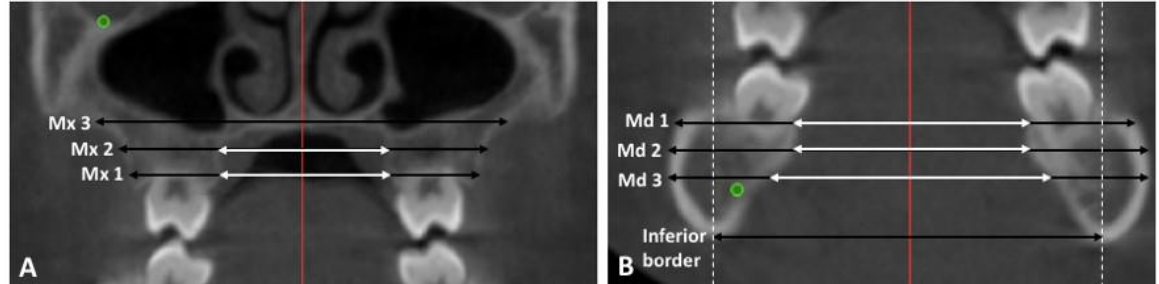
Figure 3. Dentoalveolar Measurements. ( A ) A coronal section at the mesiodistal midpoint of the maxillary first molar. The transverse width was measured at Mx 1, Mx 2, and Mx 3 at 2, 6, 10 mm apical to the U6 CEJ respectively. ( B ) A coronal section at the mesiodistal midpoint of the mandibular first molar. The transverse width was measured at Md 1, Md 2, Md 3 at 2, 6, 10 mm apical to the L6 CEJ respectively and inferior border. The black arrow shows the buccal transverse width, and the white arrow shows the lingual transverse width. The coronal and axial cross sections at which measurements were completed on the T2 image were identified by using the infraorbital and mental foramina.